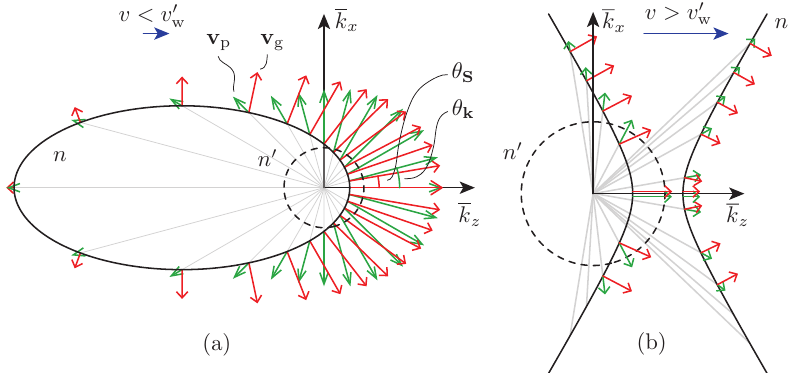
Figure 3. Dispersion relation, with phase and group velocity vectors for a moving dielectric (fluid) medium with refractive index n (cid:48) = 2 (wave velocity in the rest medium: v (cid:48) w = c /2). ( a ) Subluminal regime, with velocity v = 0.9 v (cid:48) w < v (cid:48) w ; ( b ) Interluminal regime, with v = 1.6 v (cid:48) w > v (cid:48) w . The dashed circles correspond to the isotropic curves at v =